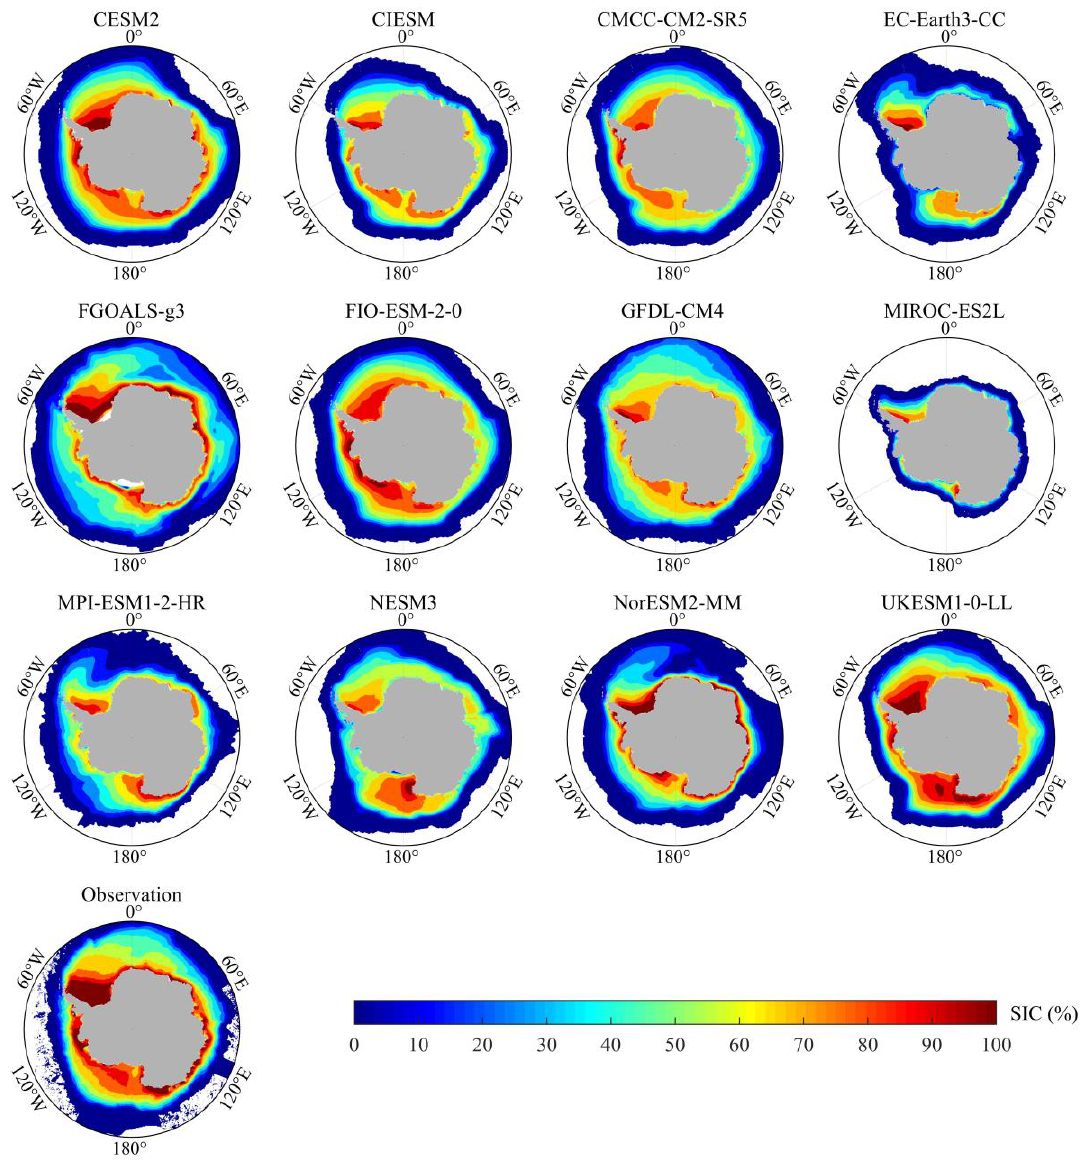
Figure 8. Spatial distributions of multi-year mean SIC for the CMIP6 models and the observation over the period 2015–2021. Areas without sea ice are filled by blank space.